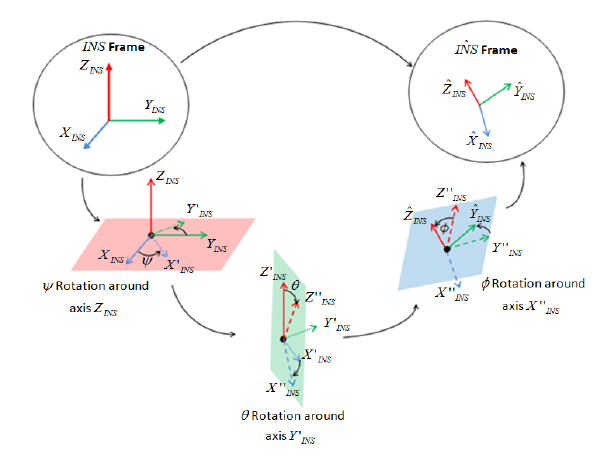
Figure 2 : Boresight angles